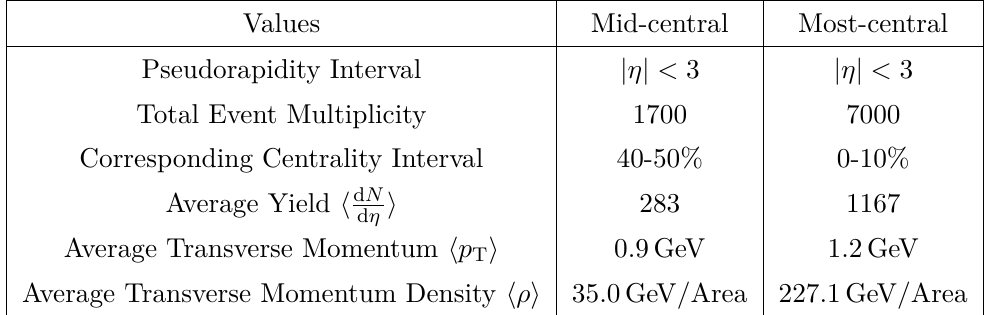
Table 1 . Parameters of the simulated underlying events.